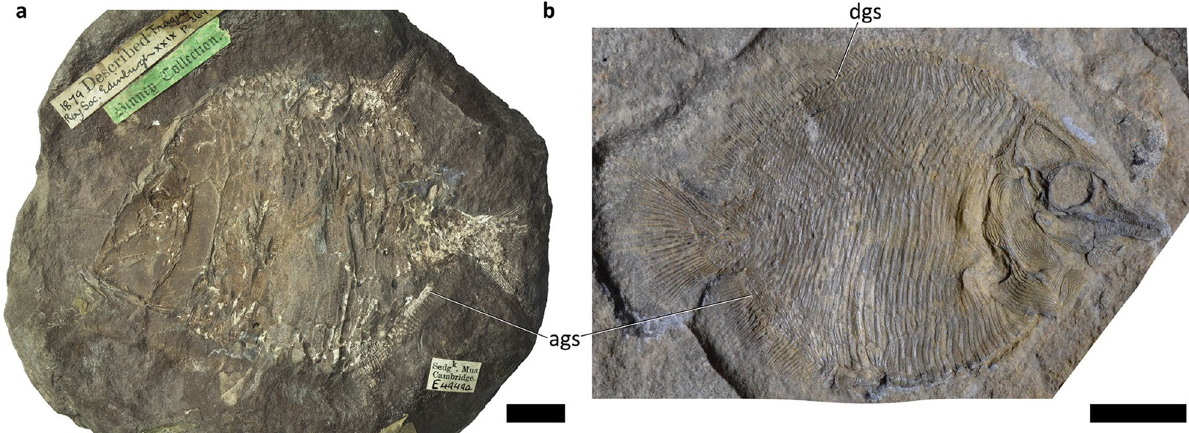
Figure 8. Other platysomids bearing anal and/or dorsal guard scales. Scale bars = 10 mm. ( a ) Platysomus tenuistriatus , SM E 4949 a in left lateral view. Photograph provided by the GB3D Type Fossils Online project, the copyright holder, at http:// www. 3d- fossi ls. ac. uk/ fossi lType. cfm? typSa mpleId= 20005 040 under a Creative Commons Attribution-NonCommercial-ShareAlike 3.0 Unported License. ( b ) Platysomus sp., FMNH PF 10792 in right lateral view. Photograph kindly provided by Jack Stack. ags, anal guard scales; dgs, dorsal guard